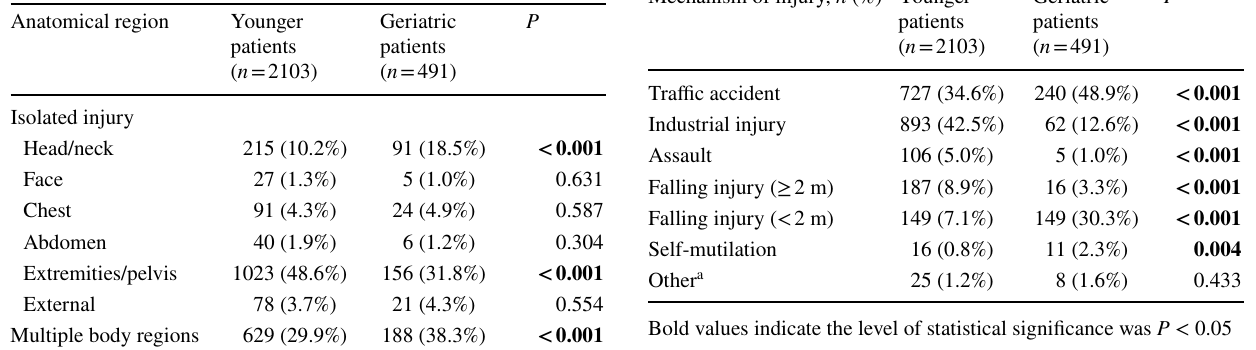
Table 2 Comparison of injured anatomical regions by patient popula- tion